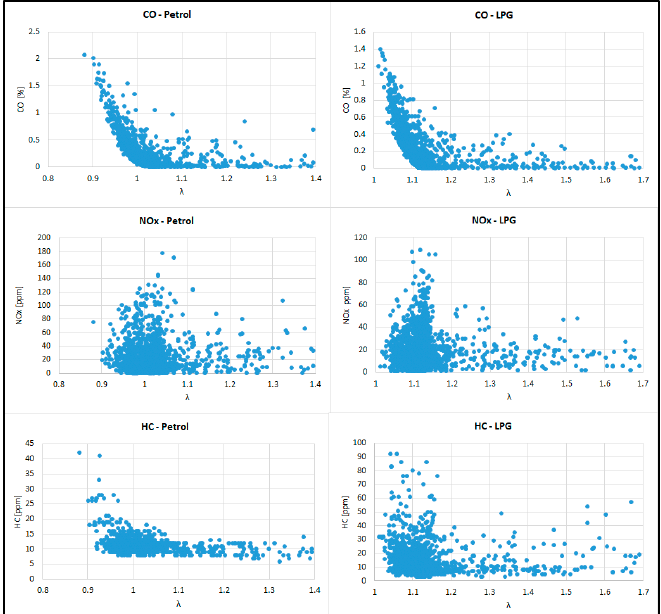
Figure 1 8 . Production of monitored emissions in relation to the excess air factor λ [author] . Figure 18. Production of monitored emissions in relation to the excess air factor λ